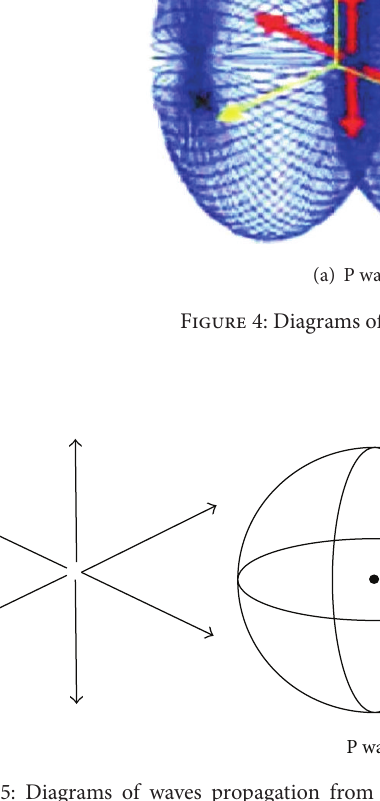
Figure 5: Diagrams of waves propagation from combination of three couples of forces.